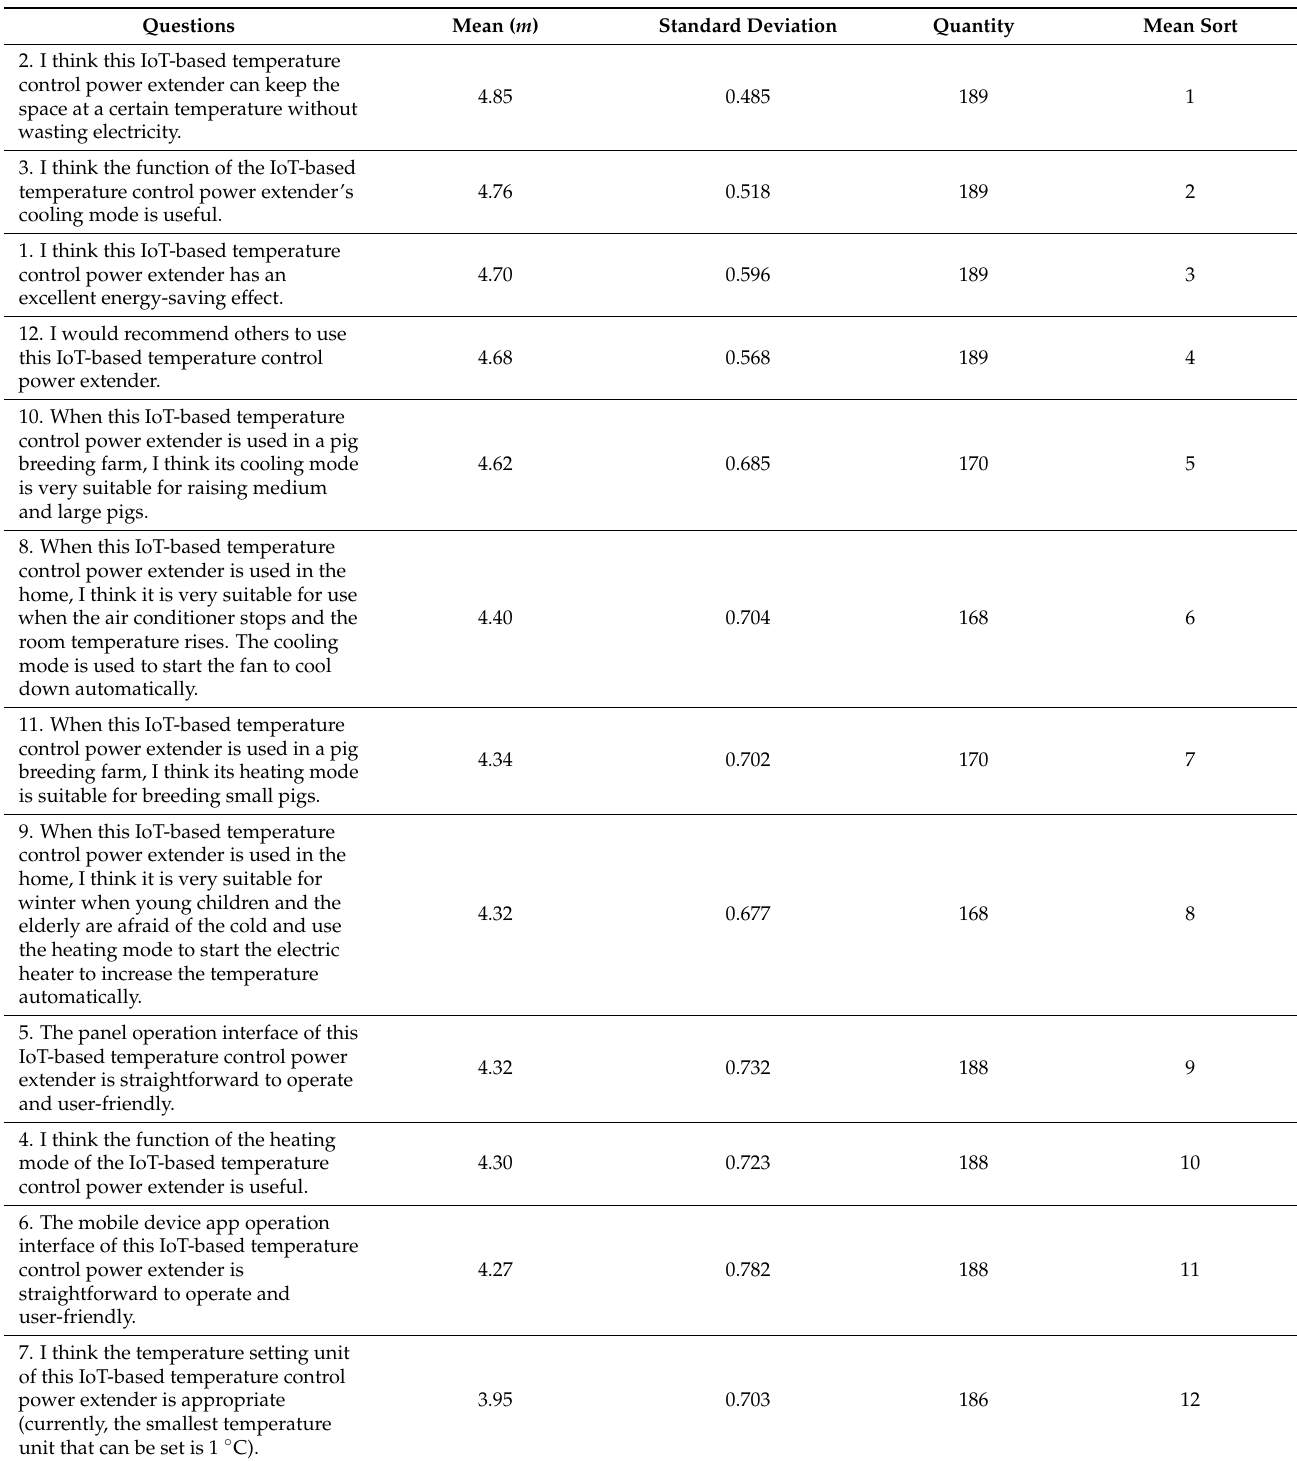
Table 5. Satisfaction analysis